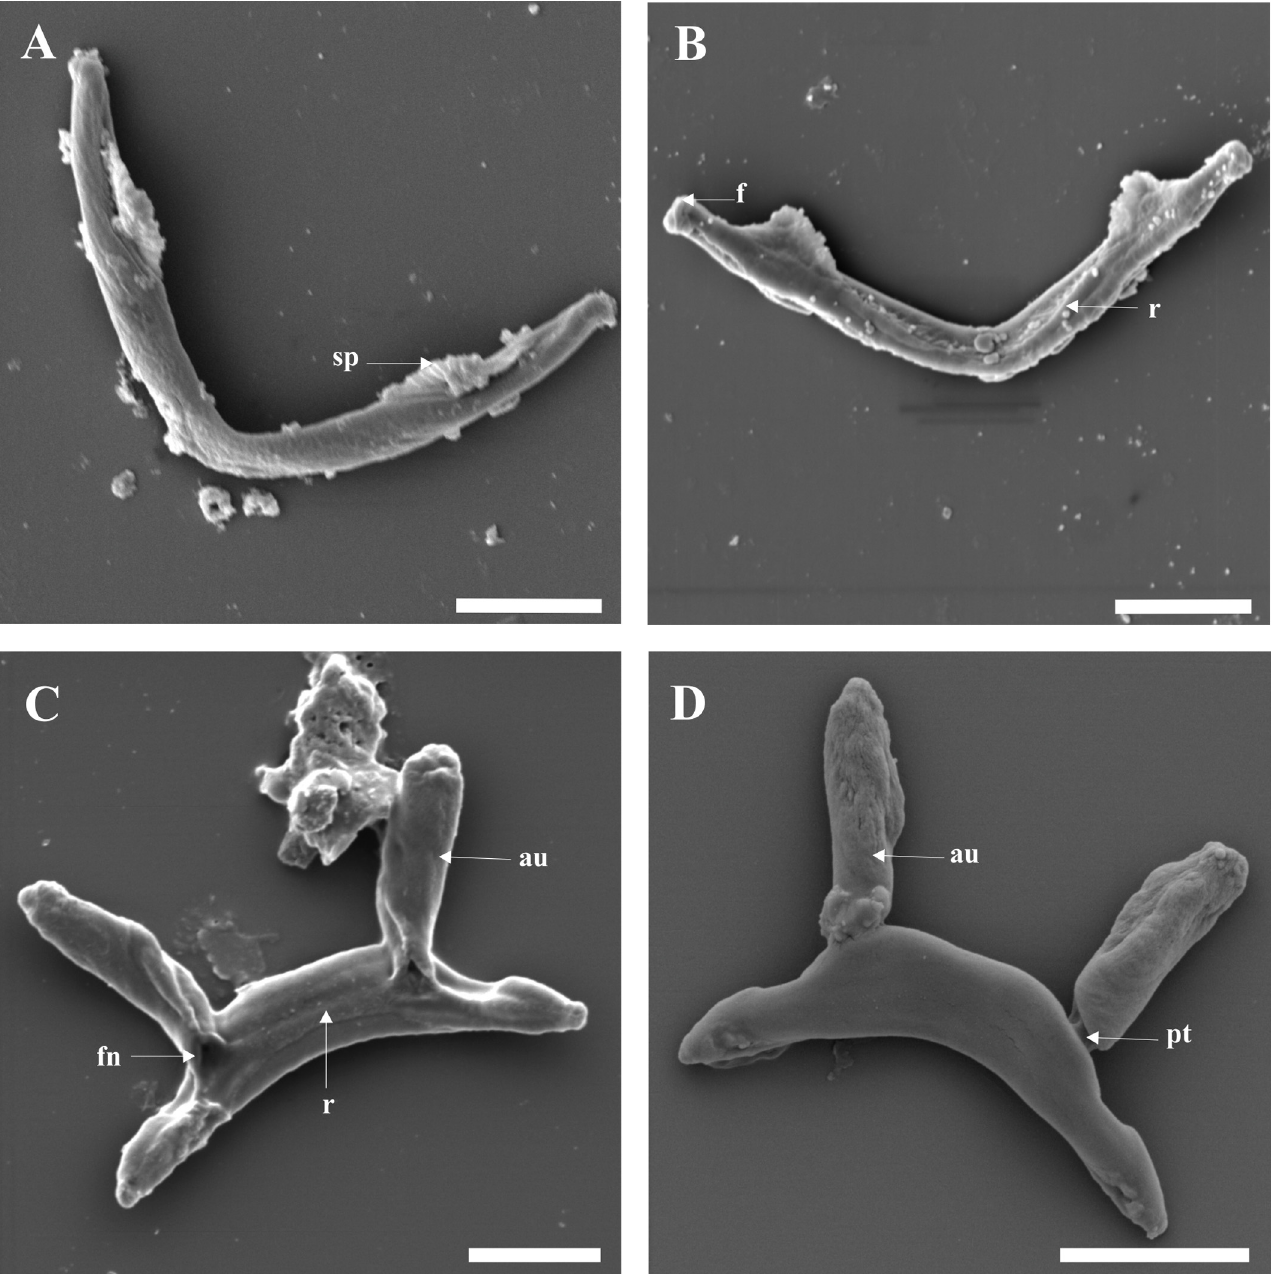
Figure 4. SEM micrographs of ventral and dorsal bars: A convex surface of ventral bar; B concave surface of ventral bar; C concave surface of dorsal bar; D convex surface of dorsal bar. Abbreviations: au auricle; f fold on extremities; fn fenestration; pt point of attachment of auricle; r rib; sp serrated plate. Scale-bars: 10 m